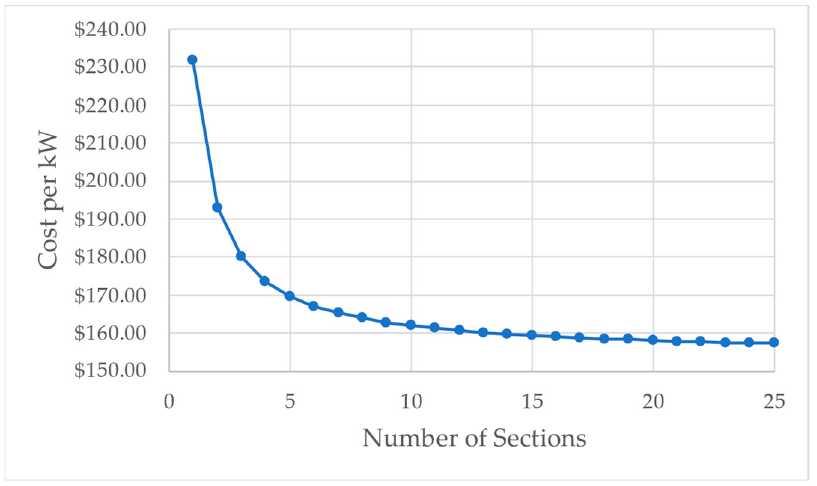
Figure 6. System cost per kW, before tax and footing costs, as a function of the number of 1.2 kW sections.